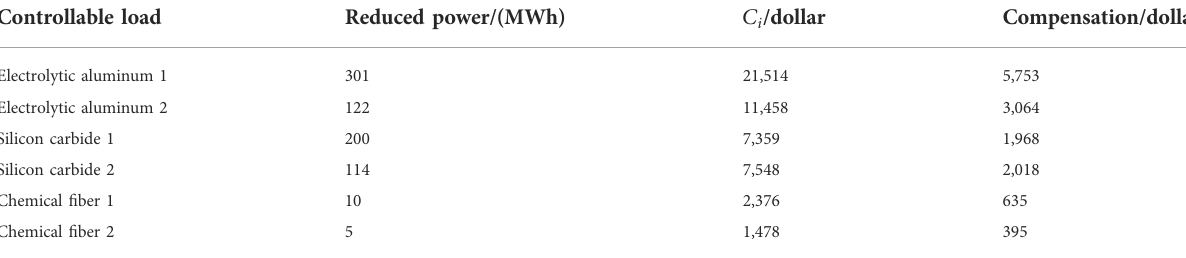
TABLE 7 Loss and compensation of the reduced loads.